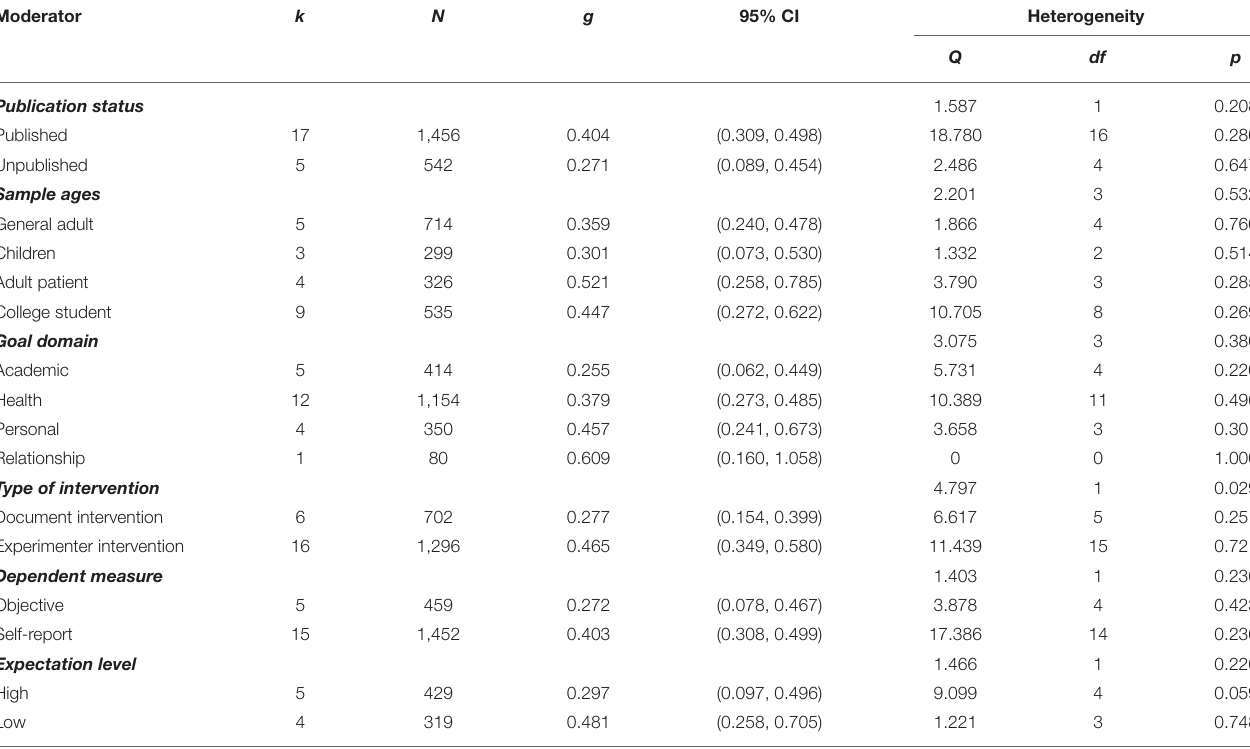
TABLE 2 | Moderators of effect